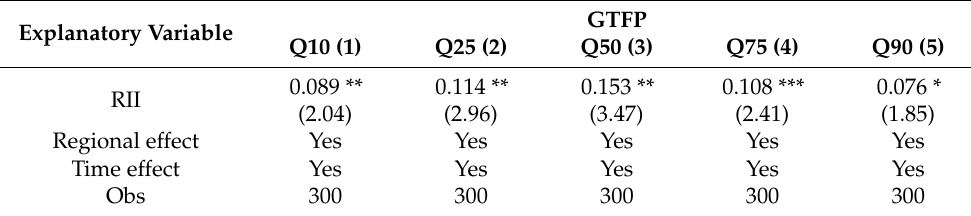
Table 5. Robustness test based on quantile